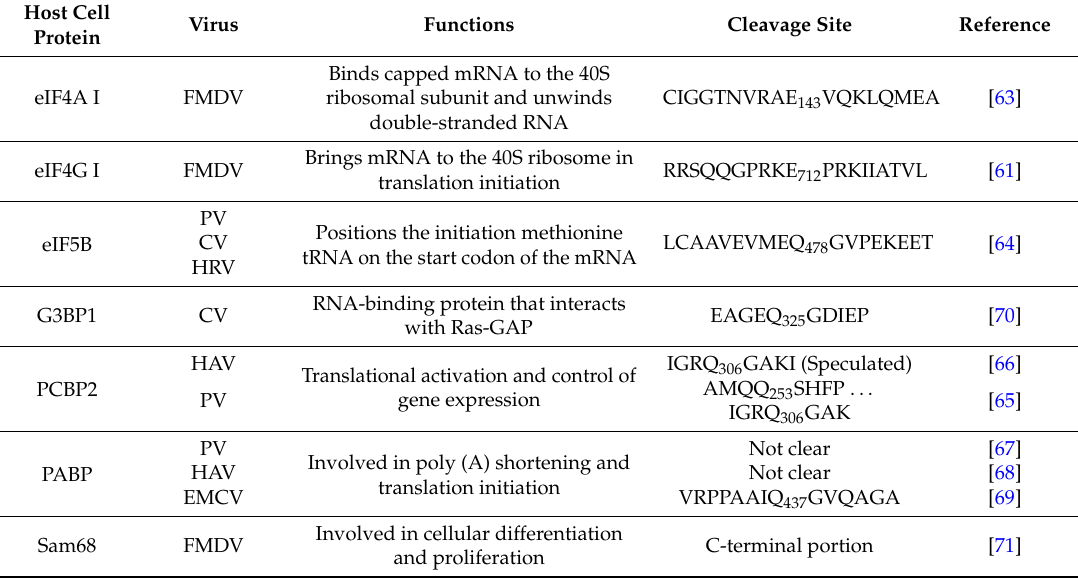
Table 2. Cleavage of translation-related proteins by 3C pro